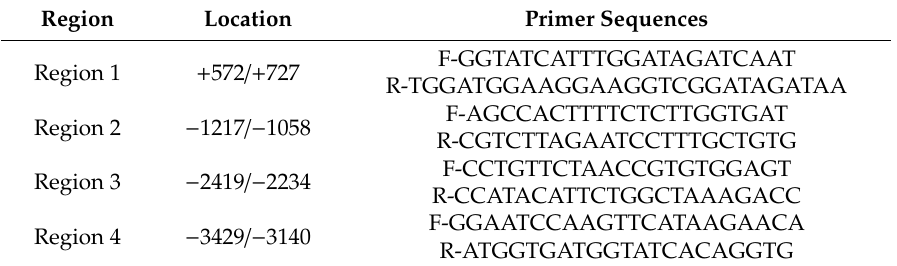
Table 2. PCR primers used for chromatin immunoprecipitation assay